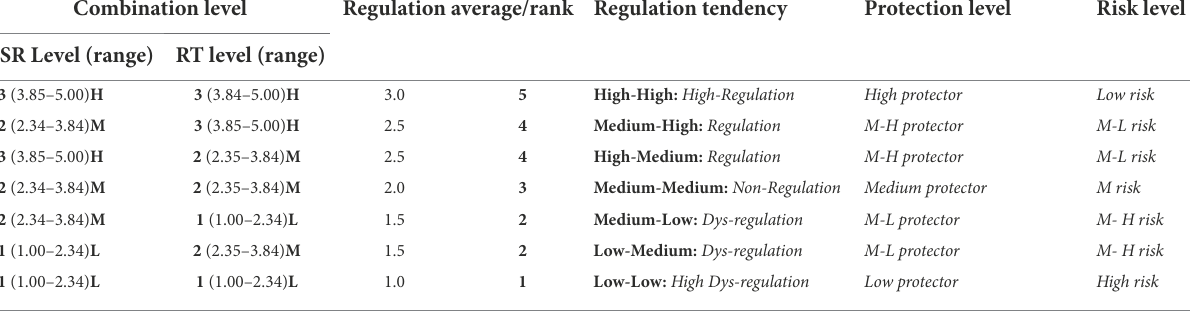
TABLE 1 Combinations of the model parameters hypothesized by SRL vs. ERL Theory (de la Fuente et al., 2019a). Combination